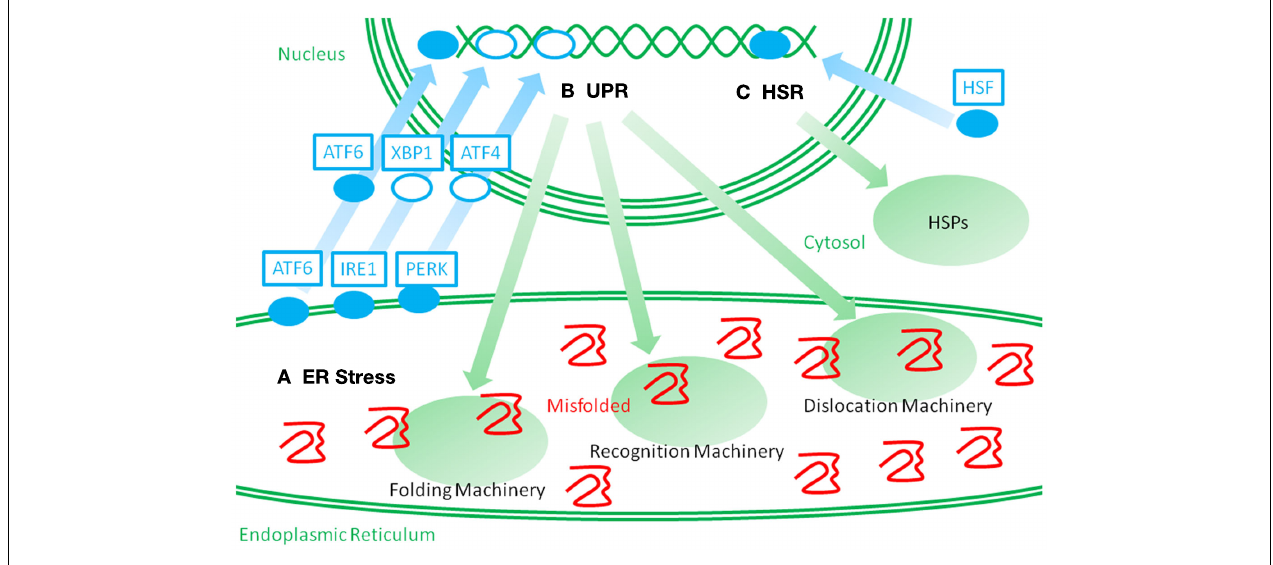
responses are called an unfolded protein response (UPR) (B) . UPR leads to an upregulation of ER stress proteins, which consist of molecular chaperones and folding enzymes, and ERAD recognition and dislocation factors. Such cross-membrane signal transduction is very different from the heat shock response (HSR) (C) .When the cytosolic stresses perturb the cytosolic protein homeostasis, heat shock factor (HSF) is activated and transmits the signal into the nucleus.Then, an upregulation of HSPs is induced. It is a challenge to recover cytosolic protein